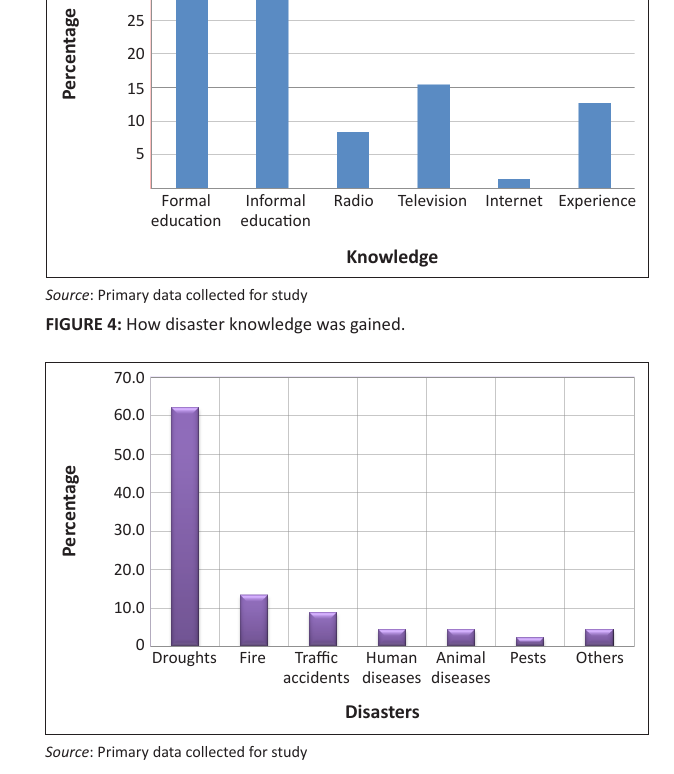
FIGURE 5: Major kinds of disasters